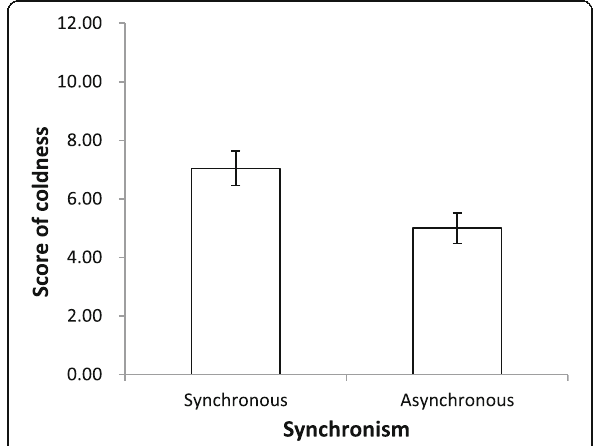
Fig. 4 Mean scores for participants ’ coldness ratings during the synchronous and asynchronous conditions. Error bars represent the standard error of the mean